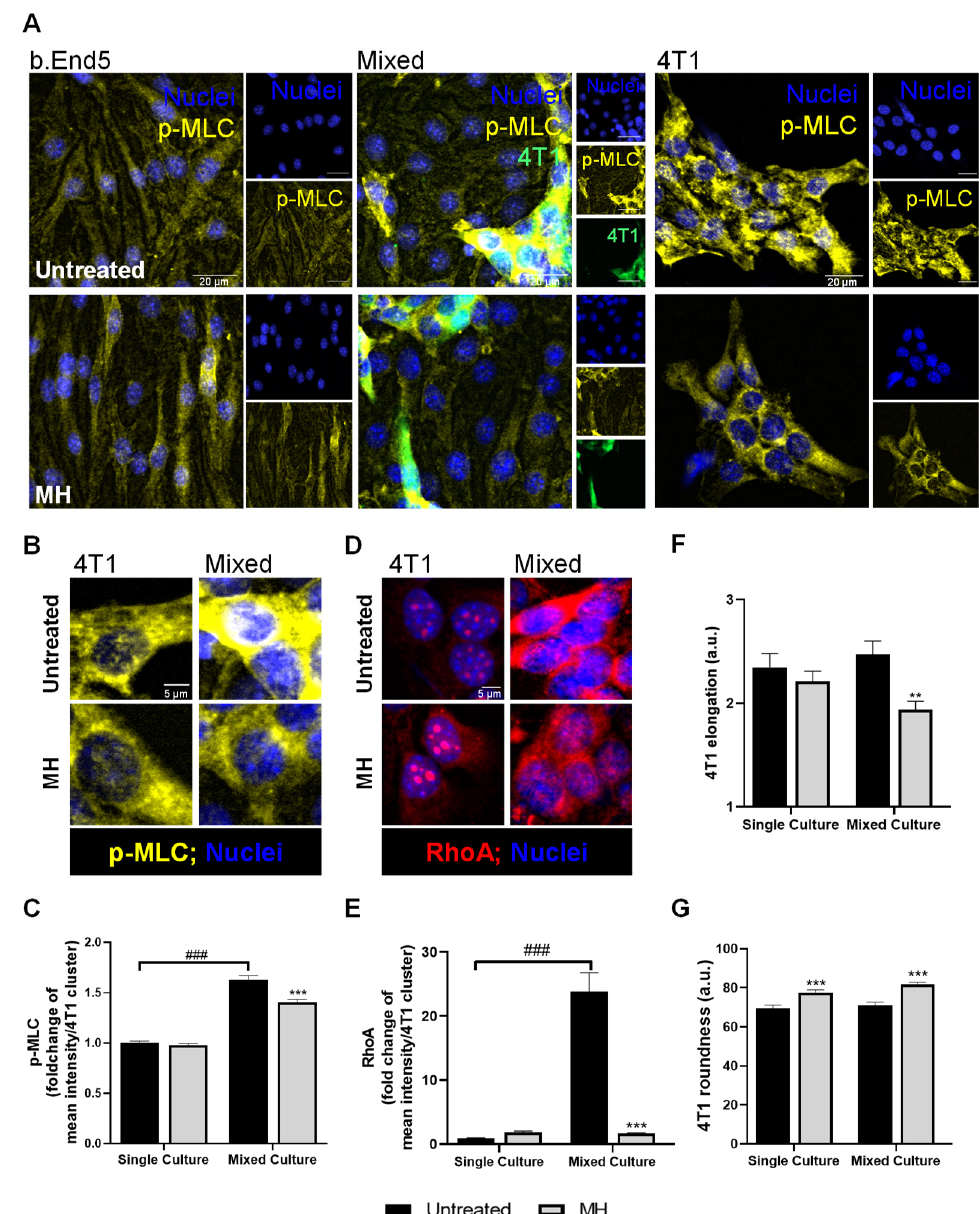
Figure 9. MH regulates endothelial and tumoural cytoskeleton-associated proteins. Confluent monolayers of b.End5 under physiological laminar non-pulsatile shear stress were exposed to 4T1 cells (previously labelled with CellTracker™ CMFDA Green Dye) and treated with MH (1 µ M), or DMEM (untreated), for 24 h, and the cytoskeleton-associated alterations were evaluated in single and mixed cultures by immunofluorescence analysis of p-MLC (yellow) and RhoA (red). ( A ) p-MLC staining highlighted a clear expression in b.End5 and particularly in 4T1 cells within ‘metastasis-like’ clusters. Hoechst 33342 was used as counterstaining for nuclei (blue). Scale bar: 20 µm. ( B , C ) A significant decrease in tumour p-MLC in mixed cultures is observed upon treatment with MH. Scale bar: 5 µm. ( D , E ) RhoA staining highlighted a clear expression in 4T1 cell clusters, particularly in mixed cultures, which is counteracted by MH treatment, ( F ) reflecting a decrease in the elongated phenotype, and increasing ( G ) the roundness of tumour cells, coherent with a decrease in invasive properties. Scale bar: 5 µm. Data are represented as mean ± SEM of three independent experiments, where 5 cells/field, 10 fields/condition were evaluated. Statistical significances are denoted as ** p < 0.01 and *** p < 0.001 vs. untreated within the same culture type, and as ### p < 0.001 between indicated conditions.